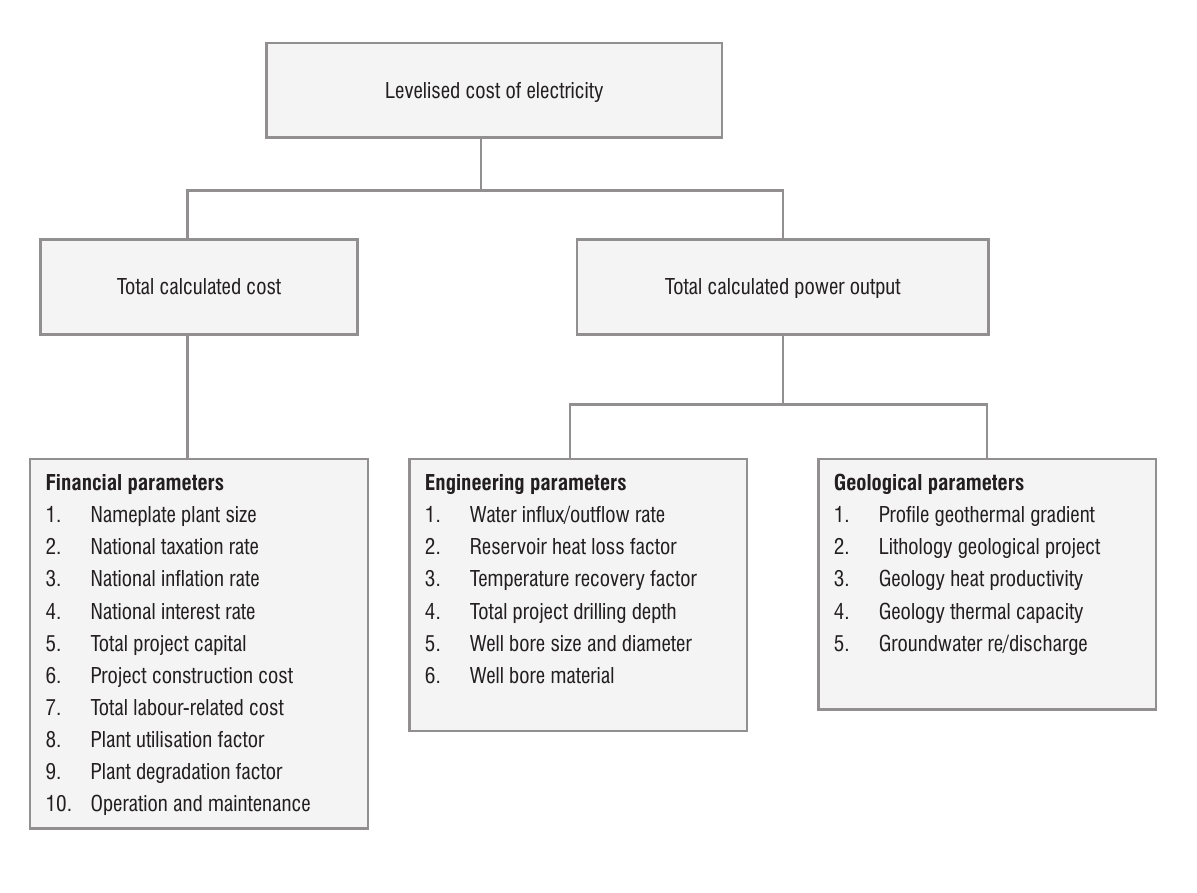
Flow diagram of the economic model developed within this study for the hypothetical enhanced geothermal